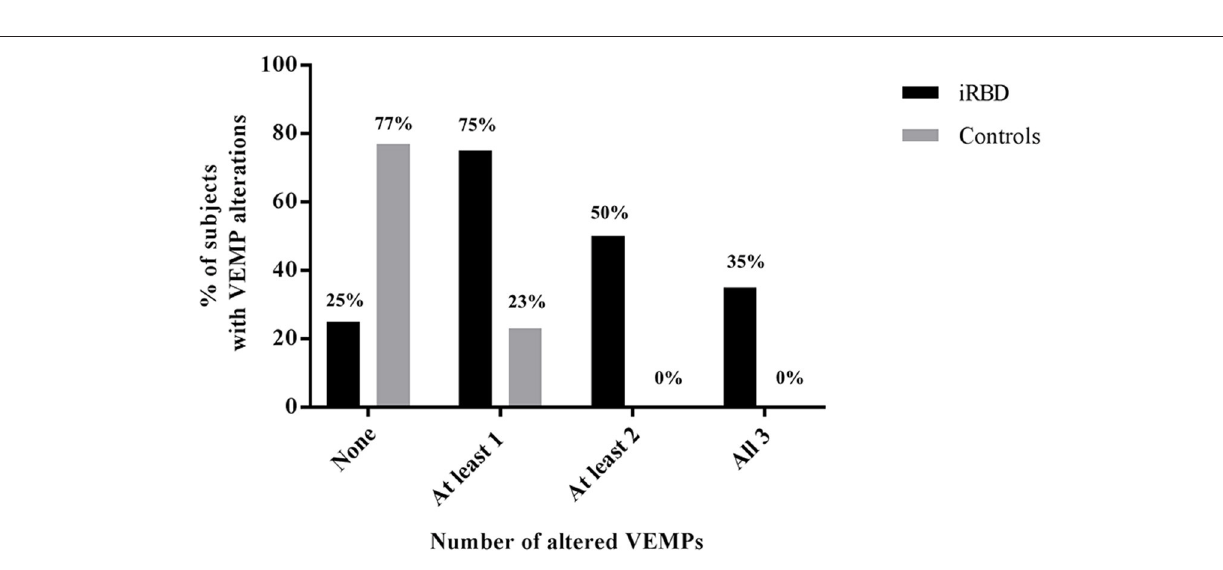
Frontiers in Neurology | www.frontiersin.org